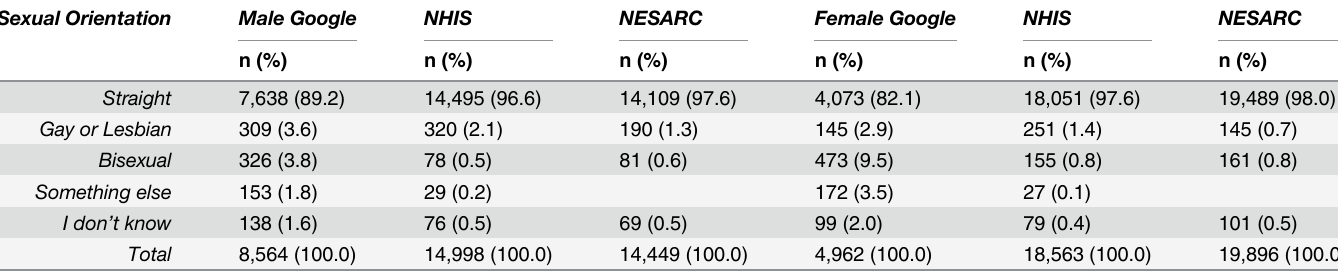
Table 2. Sexual Orientation Distributions for a Google Android Panel Sample, NHIS and NESARC.